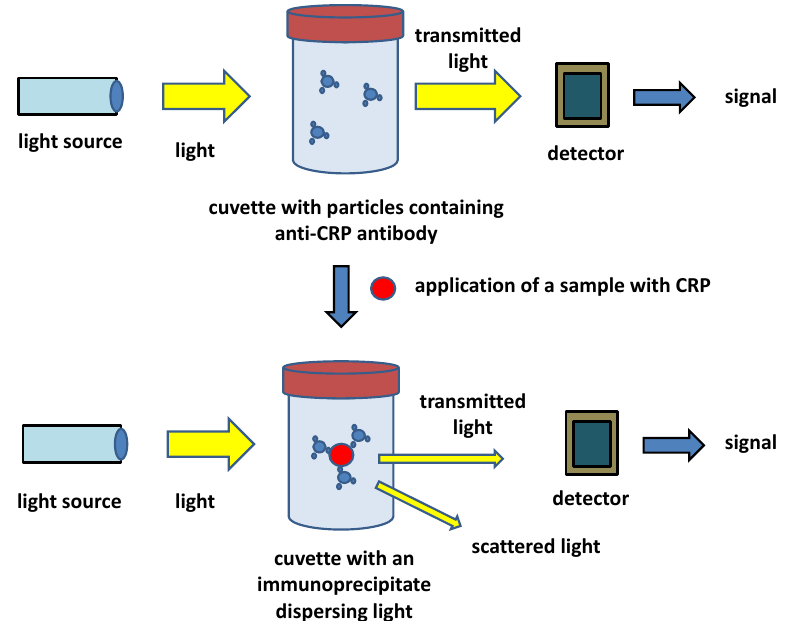
Figure 3. Principle of an immunoturbidimetric assay of CRP.